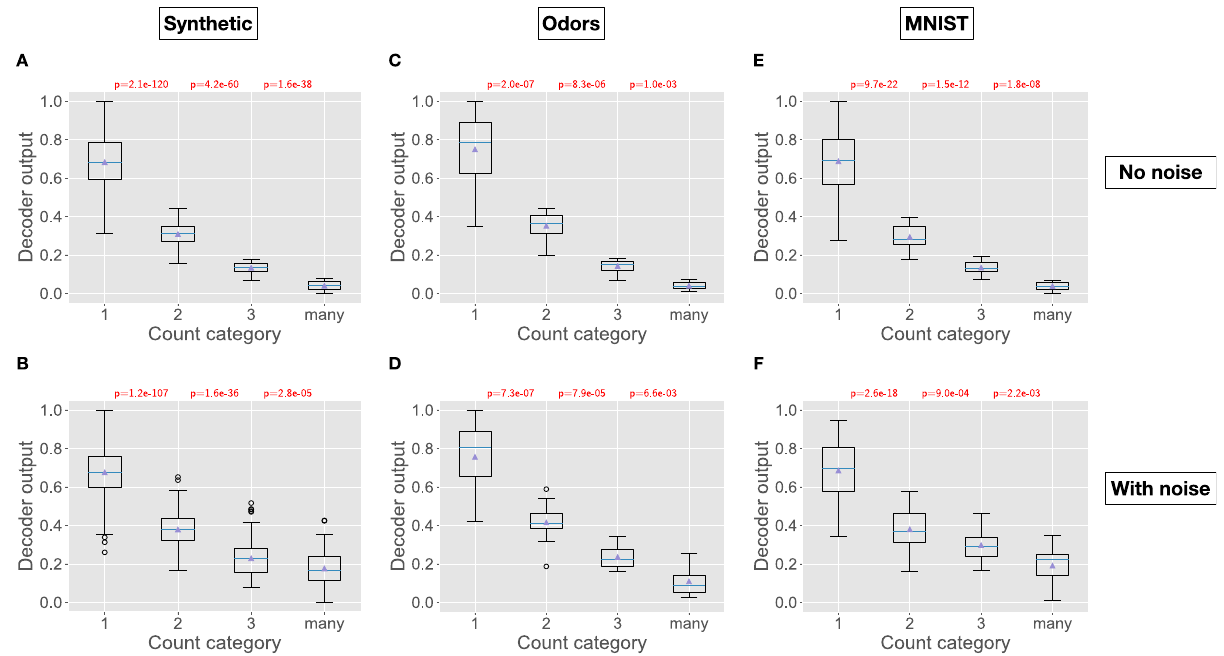
Fig. 3 | Performance of the 1-2-3-many sketch (anti-Hebbian model). In each panel, the x -axis shows the four ground-truth count categories, and the y -axis shows the decoder output from the 1-2-3-many sketch. For example, count category ‘ 1' includes all items being observed for the fi rst time (i.e., items not present in the input sequence), and the decoder output shows the response magnitude of the decoder neuron for all such items. Boxplots show the median and fi rst and third quartiles, with whiskers extending from the box by 1.5-times the inter-quartile range. Shown at the top are p -values (Wilcoxon rank-sum test,